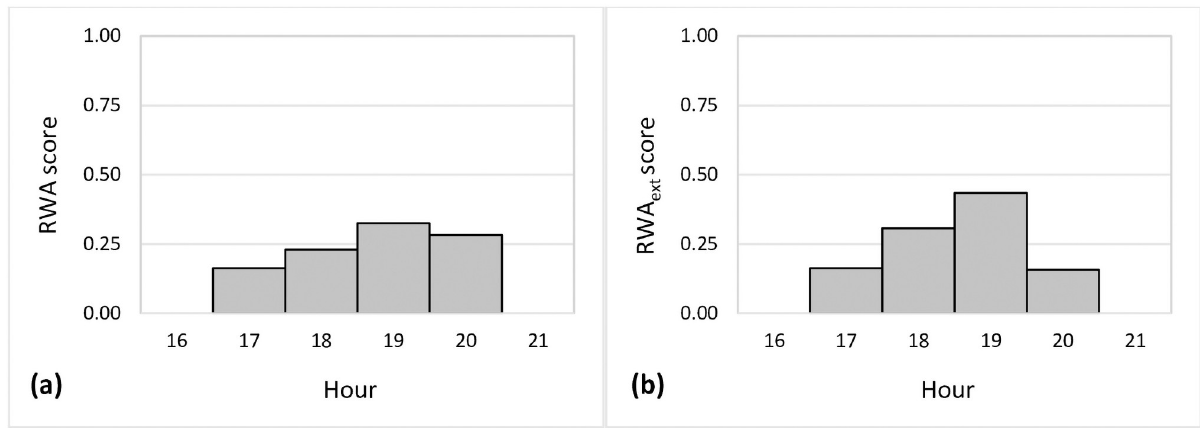
Fig 3. Distribution of scores of the RWA and RWA ext methods to estimate offense